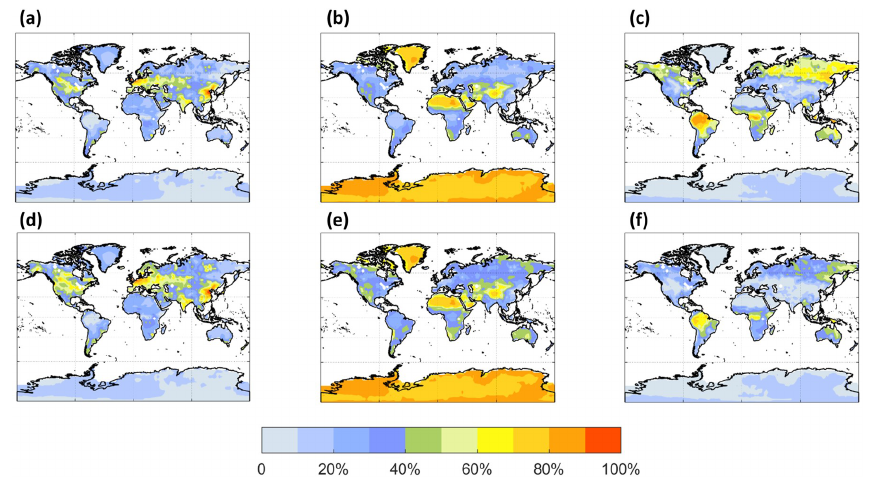
Figure 4. The annual PBL-averaged MT-HOM-RO 2 relative fates, including reaction with NO (a, d) , HO 2 (b, e) , and RO 2 (c, f) , from the LowProd_Photo (a–c) and LowProd_Photo_Slow (d–f) simulations. Reaction with NO 3 contributes < 1%; thus, it is not shown here.